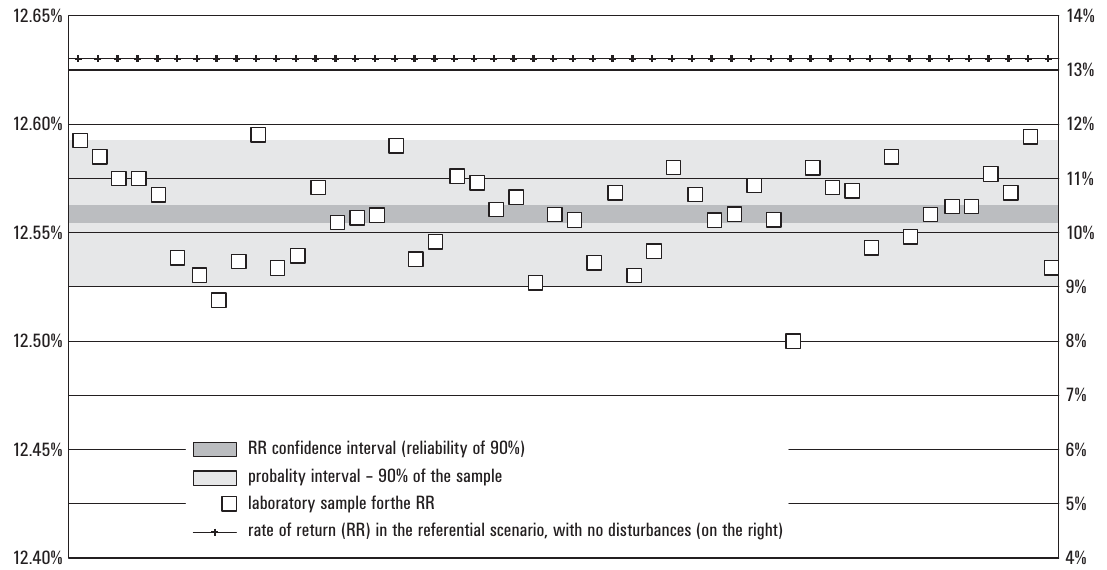
Figure 2. A laboratory sample for the rate of return of foreign investment keeping the portfolio for 20 years, in